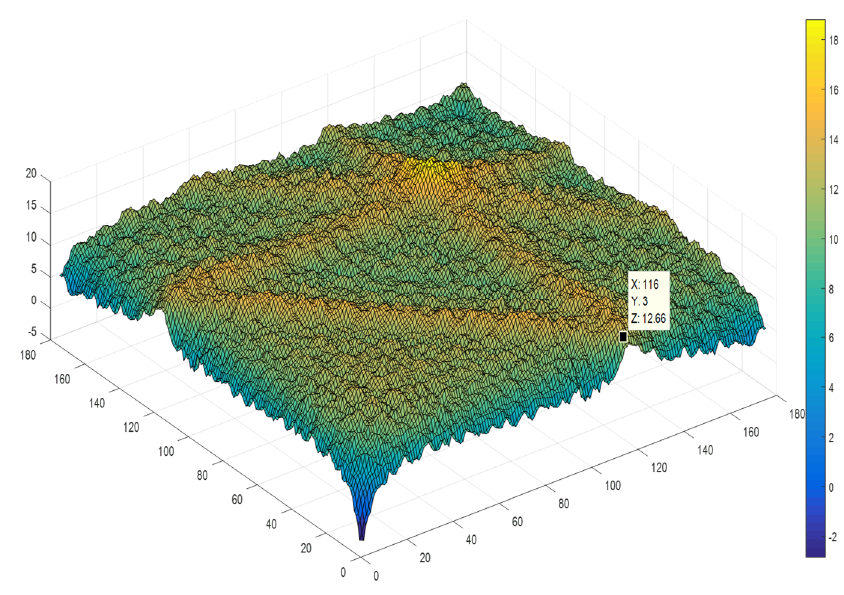
Figure 3. (Log) bicoherence matrix obtained from a 10-min ECG trace. Frequencies are multiples of 0.01 Hz, thus a value of 116 corresponds to 1.16 Hz (69.6 beats per minute).